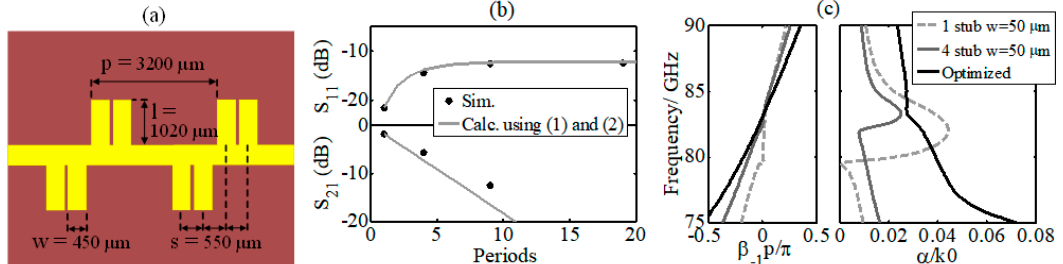
Figure 4. ( a ) Two consecutive periods along with representative geometrical parameters. ( b ) Optimized |S 11 | and |S 21 | for broadside emission as a function of the number of elements in the periodic structure (lines), and simulated values (dots). ( c ) Dispersion diagram and attenuation constant for three structures: the optimized one shown in ( a ) with 4 stubs per unit-cell and w = 450 µm (solid black lines), a 4-stub structure with w = 50 µm (solid grey lines), and a structure with a single stub per unit-cell with w = 50 µm (dashed grey lines).